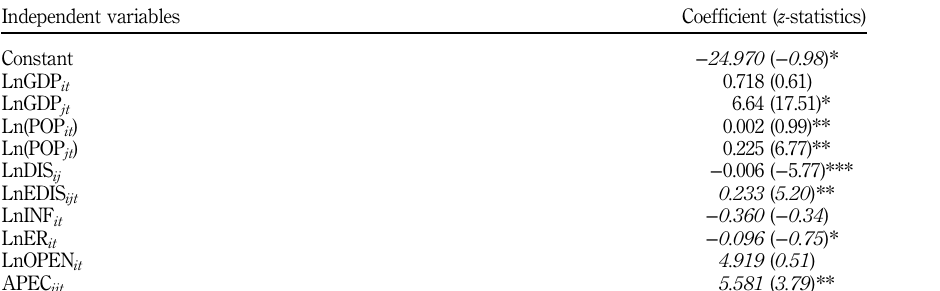
Table V. Estimation